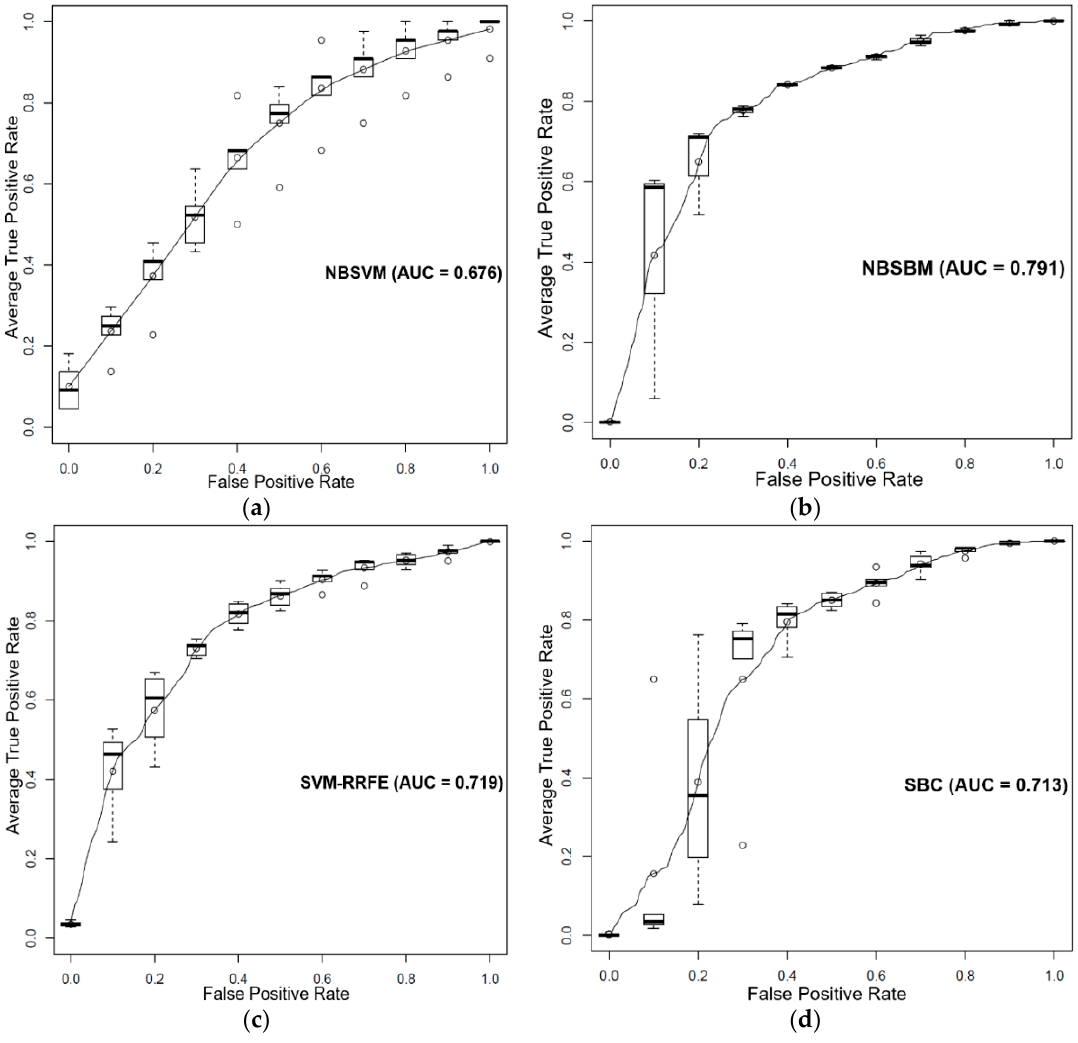
Figure 3. Comparison performance of the NBSBM with other methods in terms of average (mean) operating characteristic (ROC) curve (5-fold cross-validation and 5-repeats) and AUC value. The boxplot indicates the variation around the average ROC curve and reports the median and the interquartile range. ROC curves of ( a ) network-based SVM, ( b ) the proposed approach, ( c ) SVM-RRFE, and ( d ) sparse Bayesian classifier (SBC) to classify the response of estrogen receptor-positive breast cancer patients to Tamoxifen.